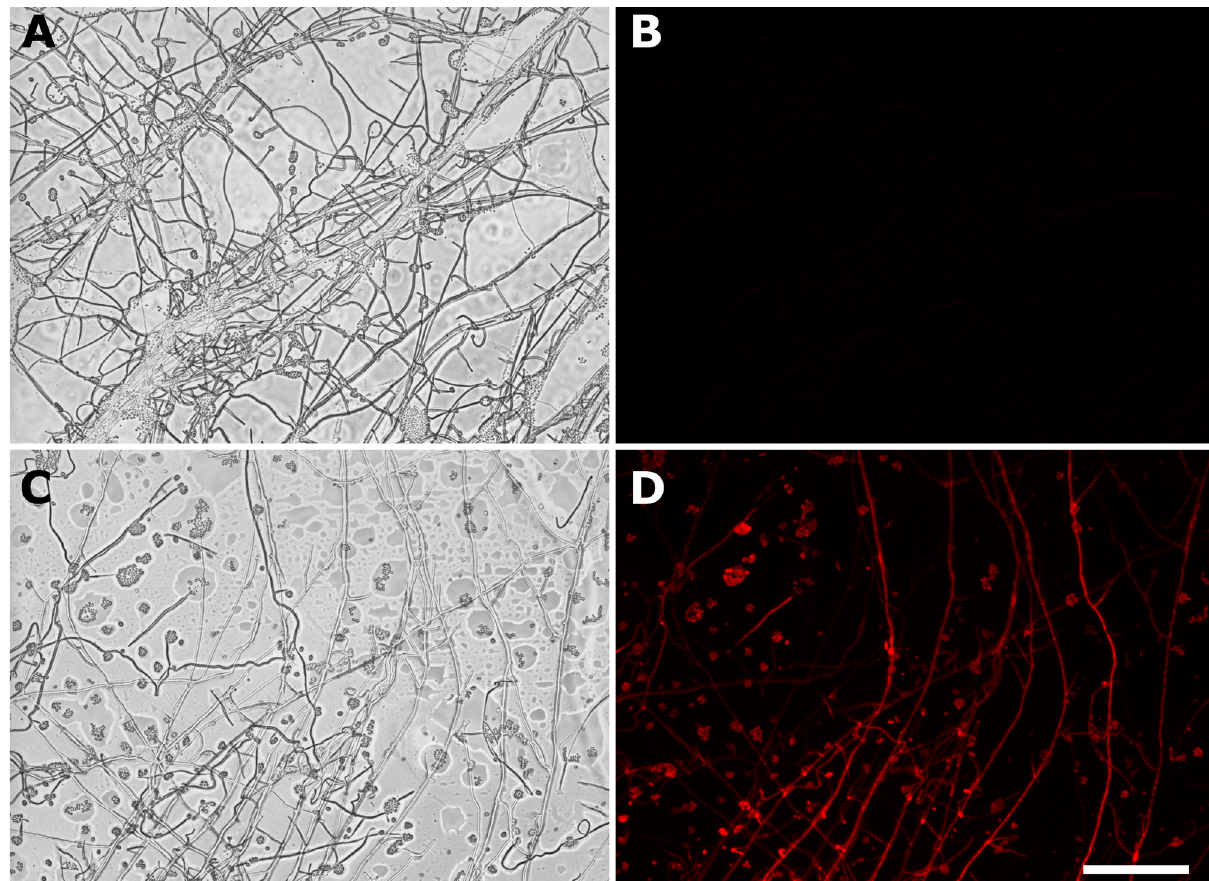
Figure 4 ‒ Microscopic evaluation of far-red Kat-fluorescence. Isolated mutants were evaluated for Kat-fluorescence employing the FLoid Cell Imaging Station. A) S. subtropicum wild-type strain relief phase. B) Wild-type red fluorescence. C) S. subtropicum mutant strain, gpdA-Kat-Sur (+), relief phase. D) gpdA-Kat-Sur (+) red fluorescence. Scale bar, 100 μm, for all